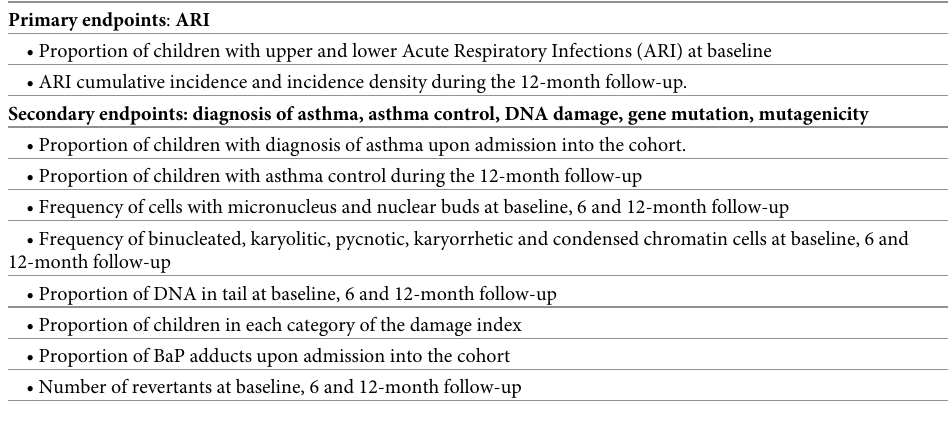
Table 1. PROMESA endpoints and related